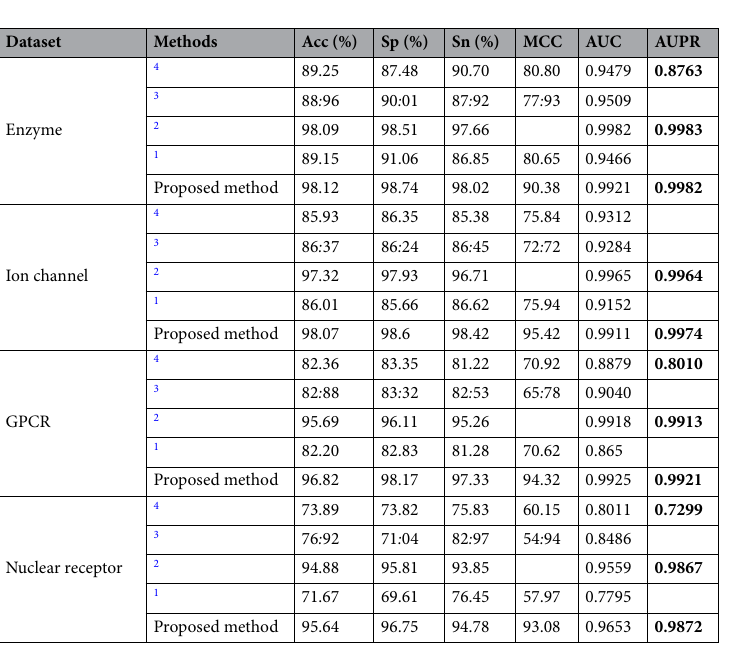
Table 7. Comparison of efficiency criteria of the proposed method and the results reported in the valid articles. Significant values are in bold.